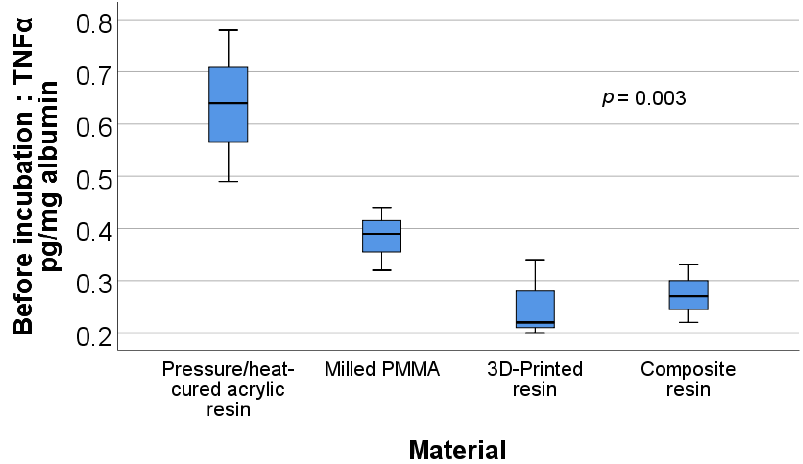
Figure 5. Box plot representation of the comparison between TNF α /albumin ratio values—before incubation for each material type.